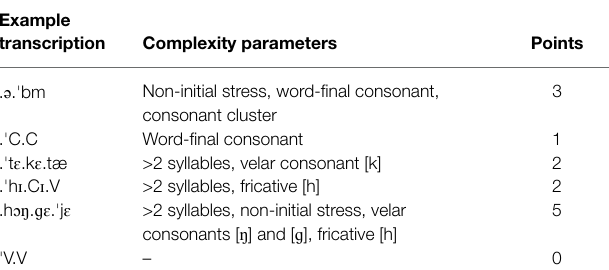
TABLE 3 | Examples of transcriptions of infant vocalizations, and WCM-SE calculations for the vocalizations. Syllable onsets are denoted by “.” and stress by “ ˈ